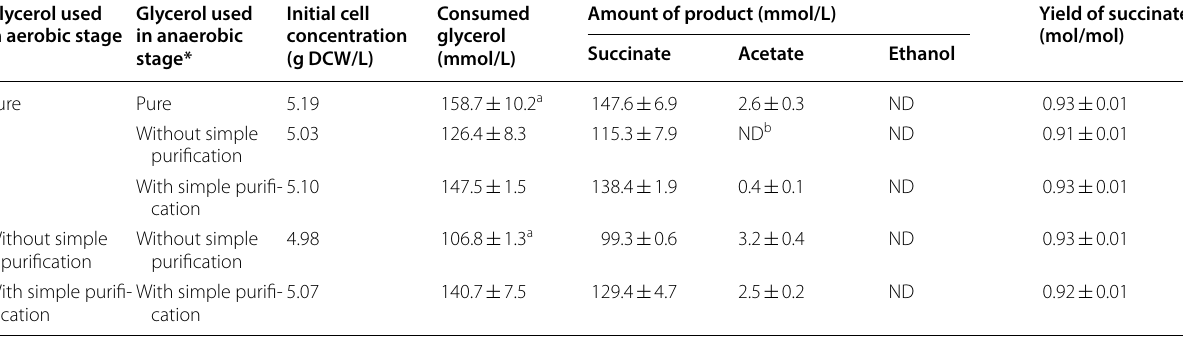
Table 1 Effect of different sources of glycerol on succinate production of the two-stage flask culture using the engineered strain MLB/pTrc99a- pck